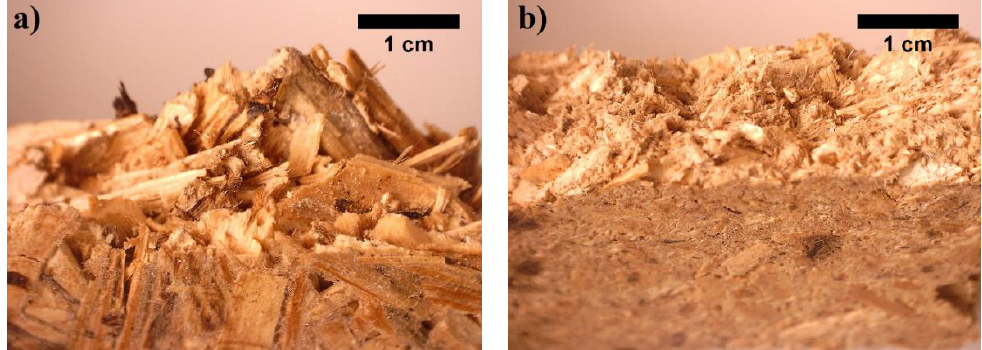
Figure 9. Nature of BcB fracture after bending test (macrostructure): ( a ) from non-shredded HS aggregate; ( b ) from shredded HS aggregate.